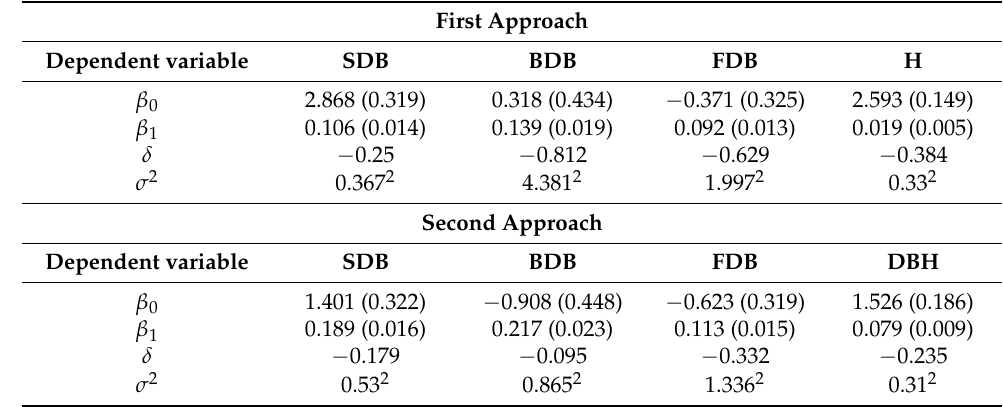
Table 3. Estimated fixed parameters and standard errors (in brackets) for two approaches of seem- ingly unrelated mixed-effects model system.